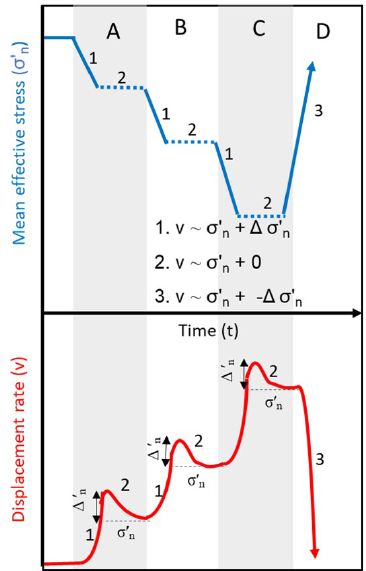
Figure 8. Conceptual model of relationship between displacement rate and mean effective stress in a landslide in response to changes in porewater